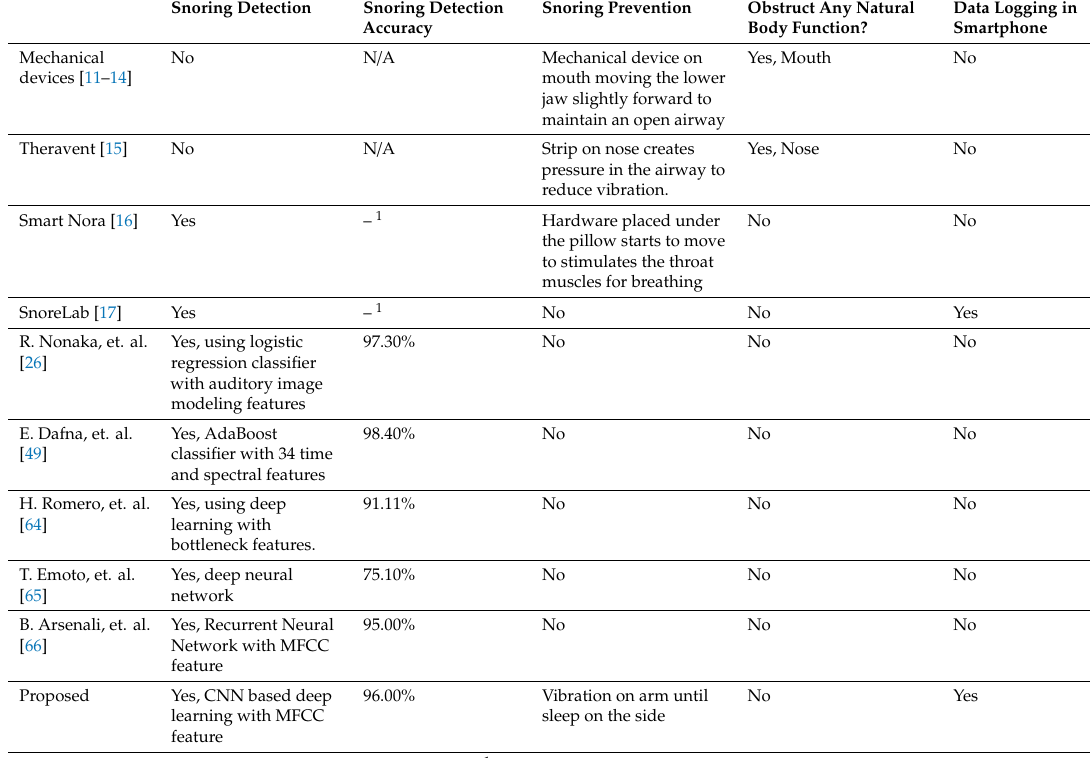
Table 2. Comparison with other